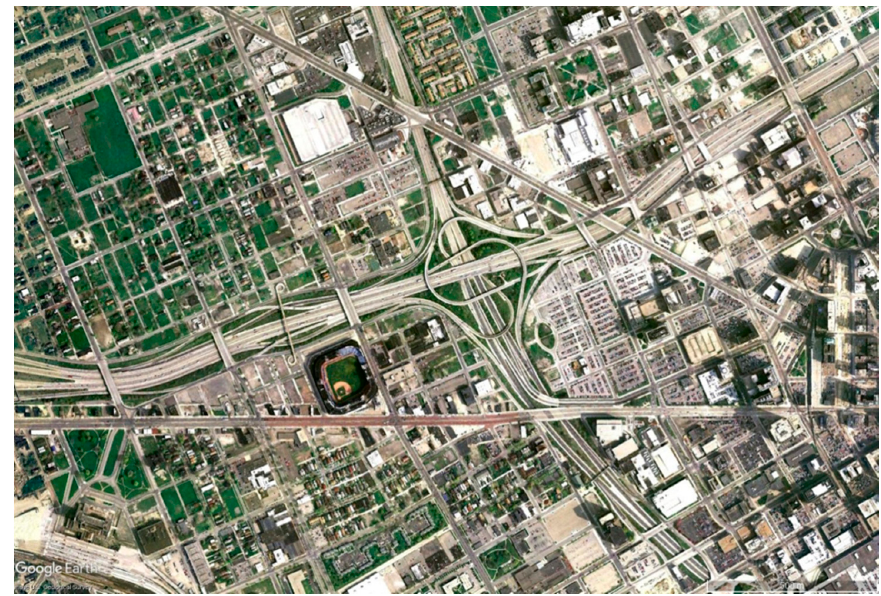
Figure 6. Fragmentation of the urban fabric in central Detroit illustrates disruptions in connectivity between neighborhoods. Source: Google Earth (14 June 2005) Image by U.S. Geological Survey.